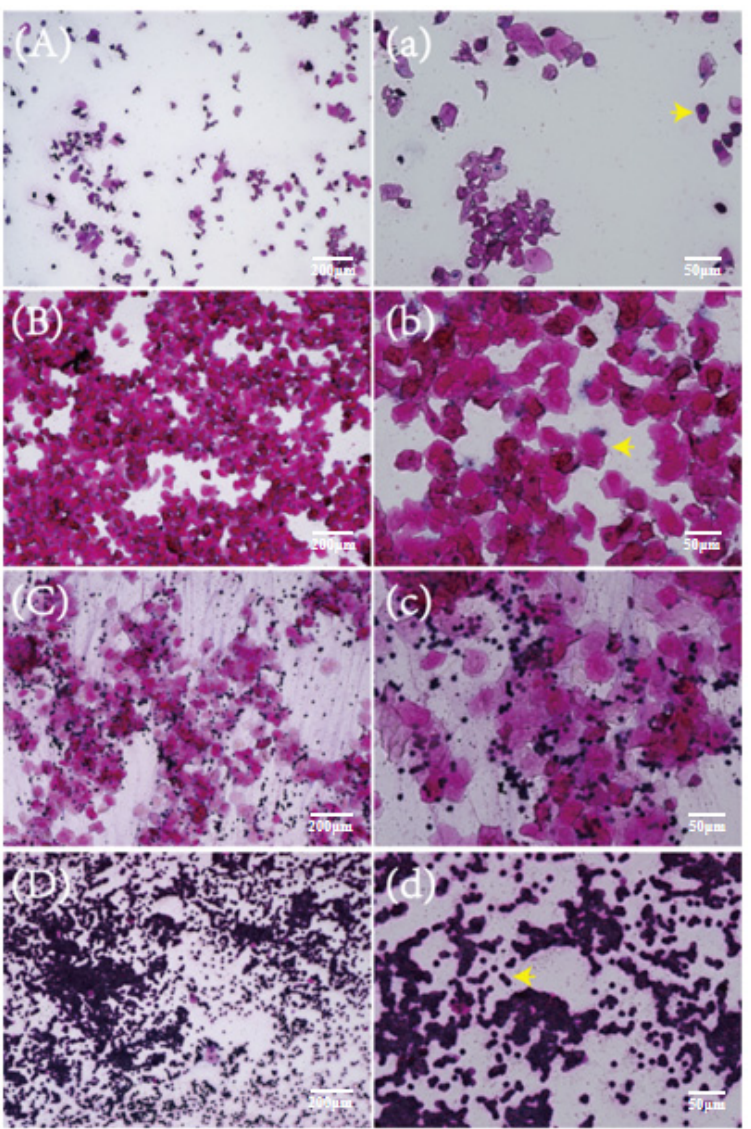
Figure 2. Vaginal exfoliated cells in different stages of the estrus cycle. ( A ) Proestrus. Nucleated epithelial cells account for the largest proportion. ( B ) Estrus. Nuclear ‐ free keratinized epithelial cells account for the largest proportion. ( C ) Metestrus. The number of leukocytes began to increase, and the cells were mainly denucleated keratinocytes and leukocytes. ( D ) Diestrus. Leukocytes account for the largest proportion. ( A – D ) scale bar = 200 μ m. ( a – d ) scale bar = 50 μ m. The arrow in ( a ) indicates nucleated epithelial cells; the arrow in ( b ) indicates nuclear-free keratinized epithelial cells; the arrow in ( d ) indicates leukocytes.